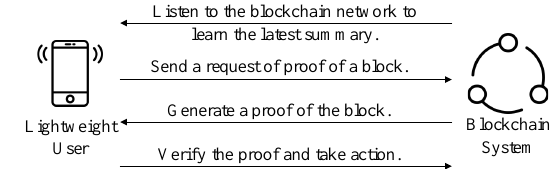
Figure 2. Illustration of the blockchain verification protocol. The nodes in the blockchain system with bigger storage capacities can keep a full copy of the blockchain. These nodes will interact with the lightweight users to help the latter to verify the validity of